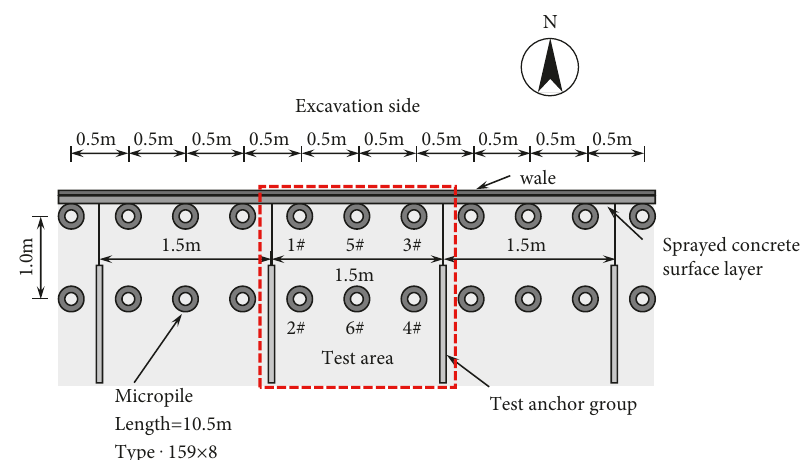
Figure 4: Layout plan of double row micropiles and anchors composite retaining structure test area.